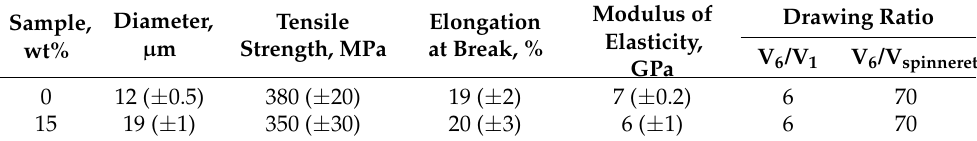
Table 4. Mechanical properties of fibers obtained from PAN solutions with silica by wet spinning (at the polymer weight).